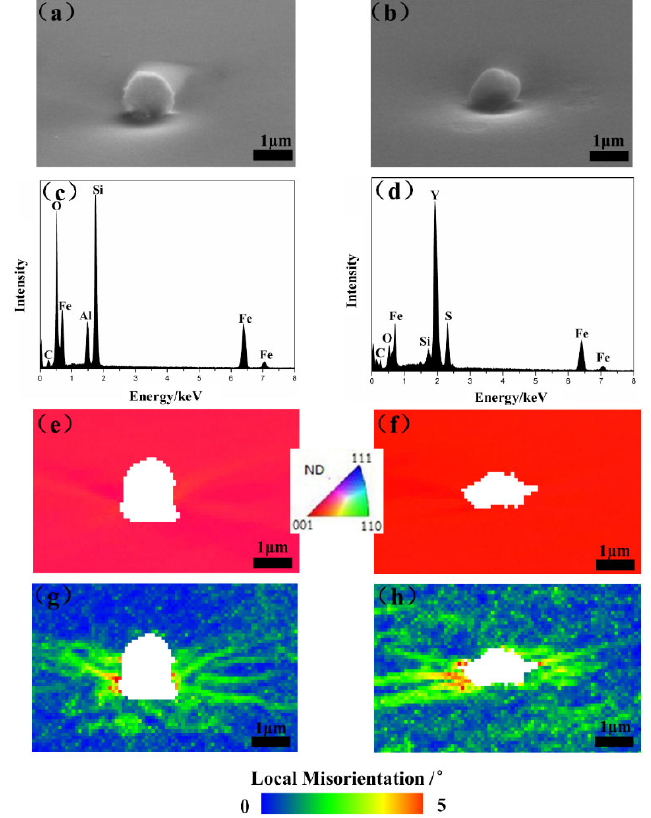
Figure 7. Micrographs around the Al 2 O 3 ( a , c , e , g ) and Y 2 O 2 S ( b , d , f , h ) inclusion. ( a , b ) SEM micro ‐ graph; ( c , d ) EDS results; ( e , f ) IPF map; and ( g , h ) local misorientation